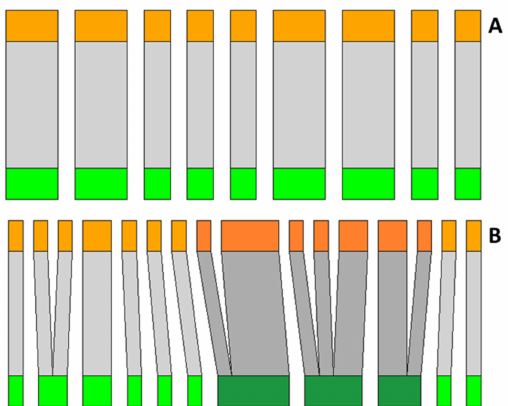
Figure 6. Examples of plant–galling insect networks sampled in the study. For each network, green bars represent host plant species and orange bars represent galling insect species. Gray bar thickness is proportional to the number of interactions of each species (drawn at di ff erent scales). ( A ) Structure of a network without the presence of superhost species (area 13; Table 2). ( B ) Structure of a network with presence of three species of superhost plants (area 5; Table 2). Species of Qualea and their galling insects are represented by dark green and orange bars,